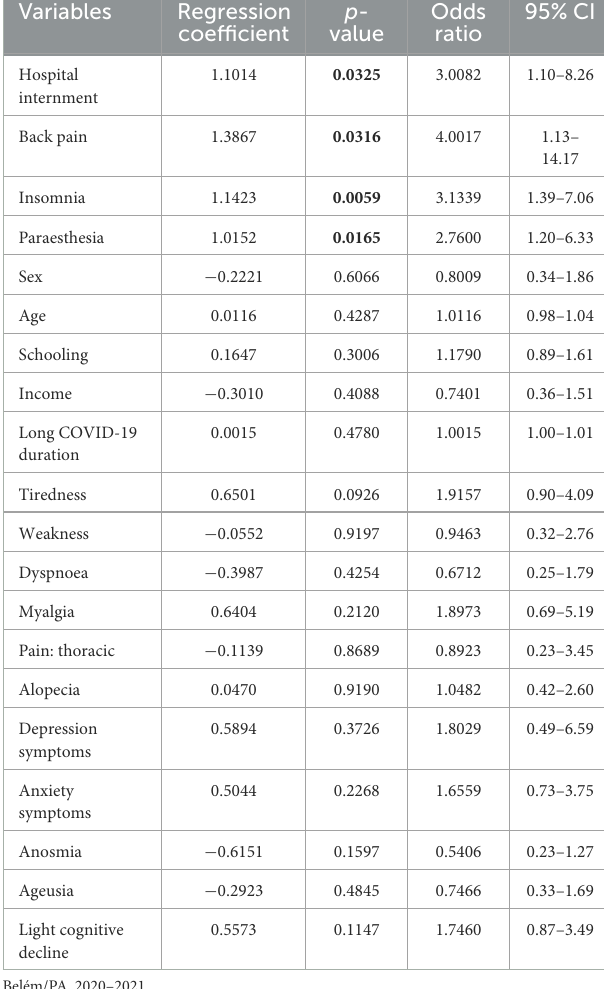
TABLE 4 Multiple logistic regression of factors that may contribute to headache in long COVID-19. Variables Regression